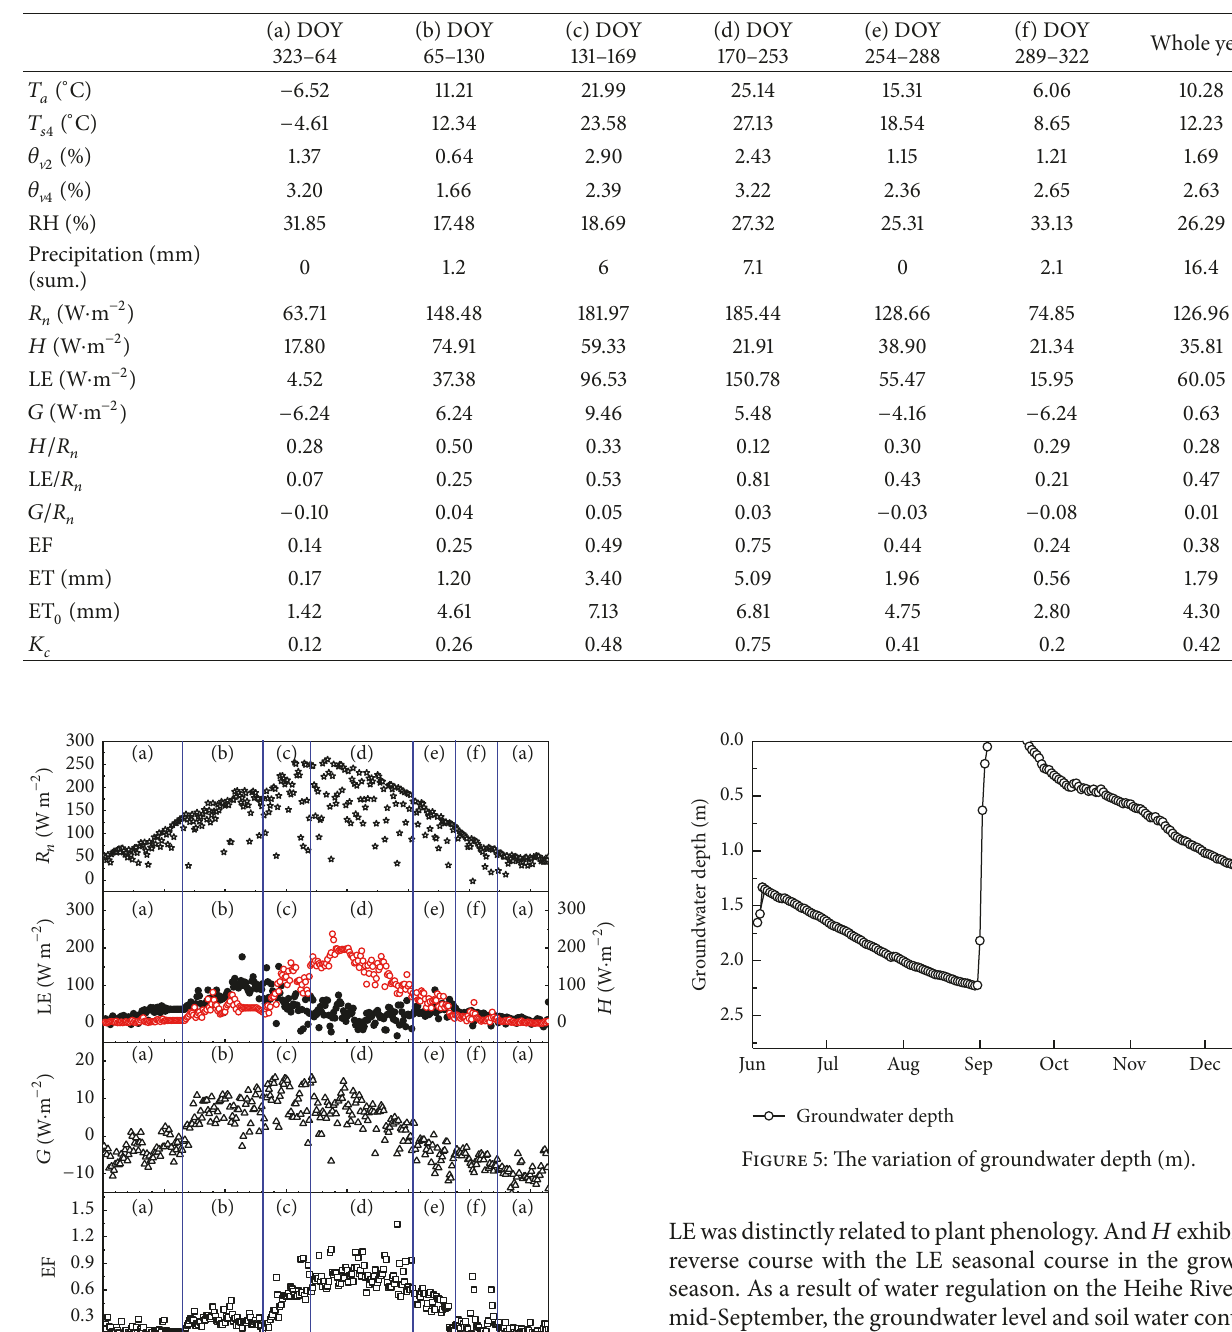
Table 1: Daily means of the energy balance components and major biometeorological factors.